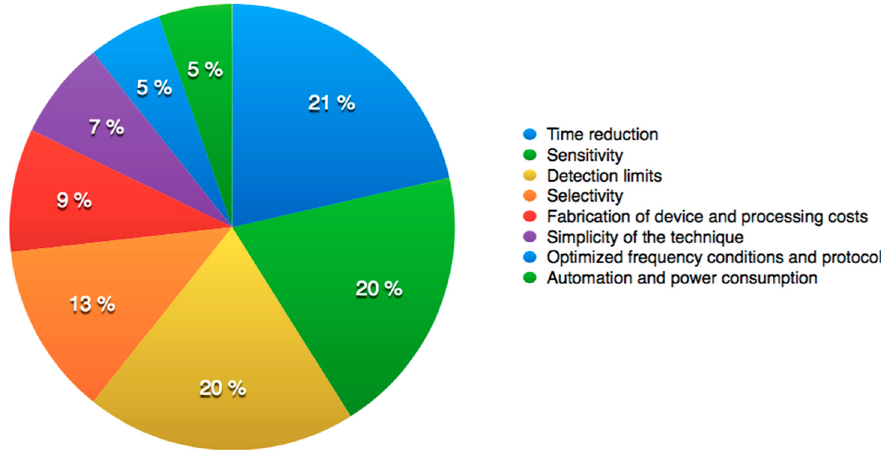
Figure 2. Addressed technical challenges that combined DEP and IA for bacteria analysis found in WOS publications from 1990 to 2015.